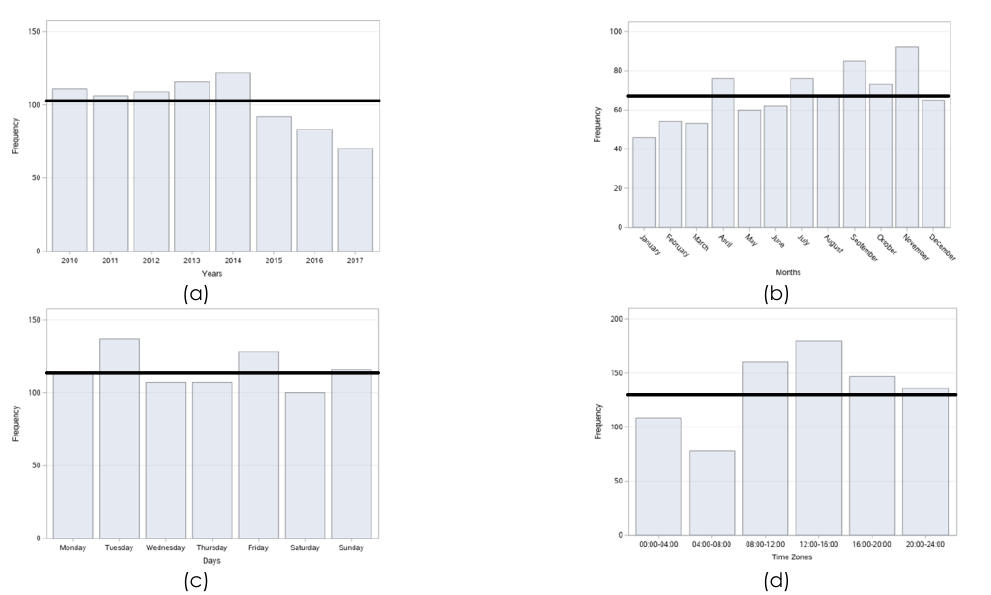
Figure 18. Bar graphs of traffic accidents on Büyükdere Street in Şişli district: (a) By years; (b) By months; (c) By days; (d)